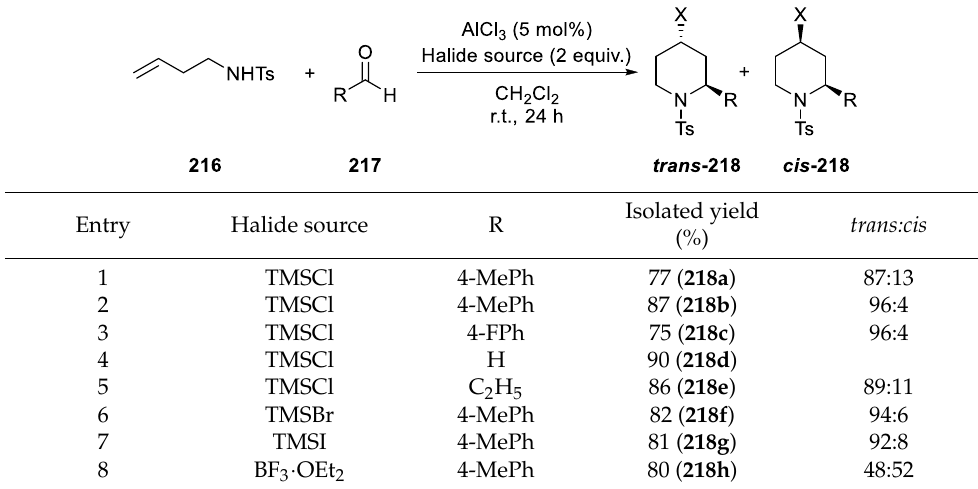
Table 8. AlCl 3 -catalyzed Prins reactions of different aldehydes with N -tosyl homoallylamine. Table 8. AlCl 3 - catalyzed Prins reactions of different aldehydes with N - tosyl homoallylamine.